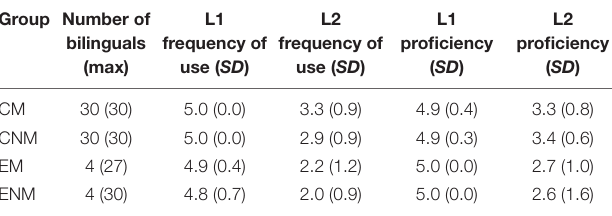
TABLE 2 | Language background of the bilingual Cantonese and English musicians and non-musicians.